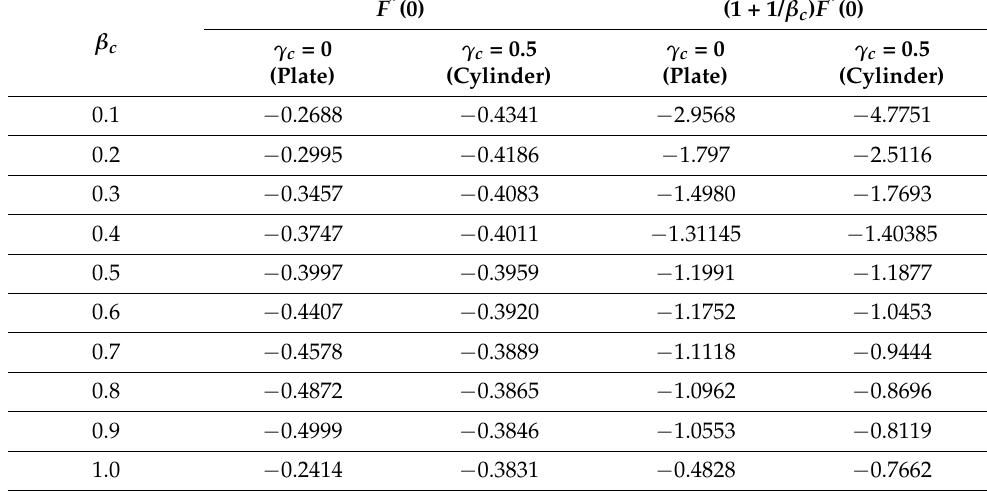
Table 8. Variation in SFC for β c when M p =